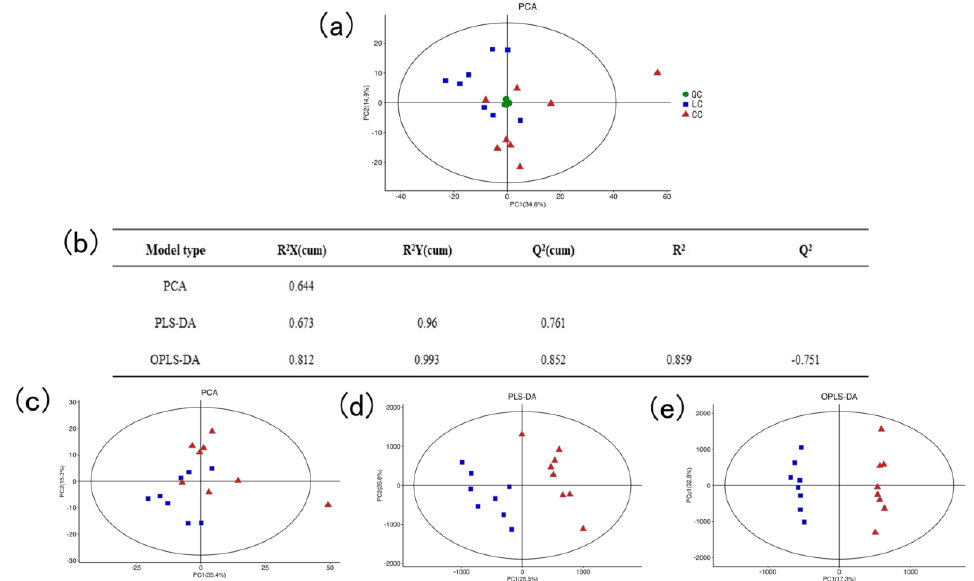
Figure 1. Total ion chromatogram of liver metabolites in ( a ) ES(+) mode and ( b ) ES( − ) mode. 8.0 e7 of the ordinate means 8 × 10 7 , the other numbers are the same.